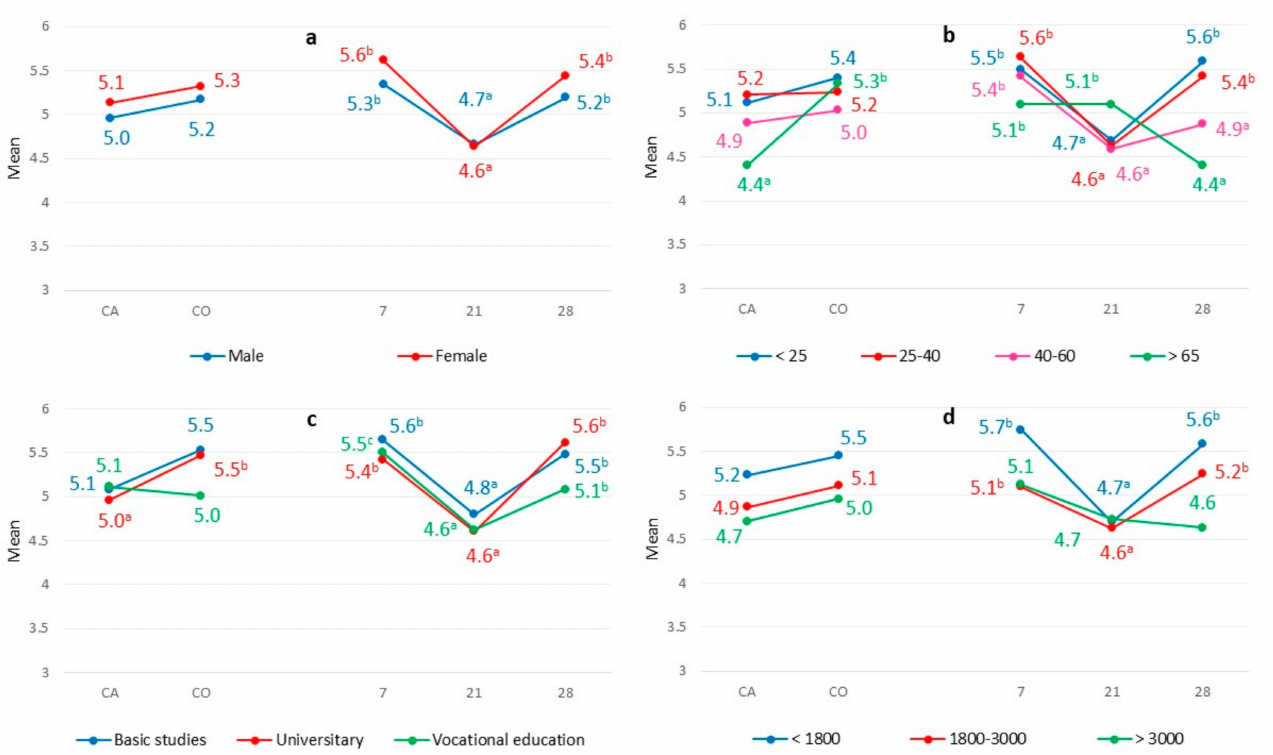
Figure 2. Overall assessment from different feeds (CA, by-product-based diet; CO, conventional feed) and aging (7, 14, and 21 d) for consumer segments according to gender ( a ), age ( b ), educational level ( c ), and income level ( d ). Means with different superscripts are statistically different ( p <